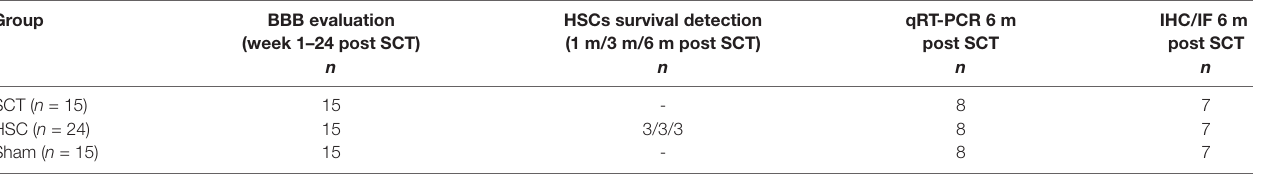
TABLE 1 | The number of animals in each